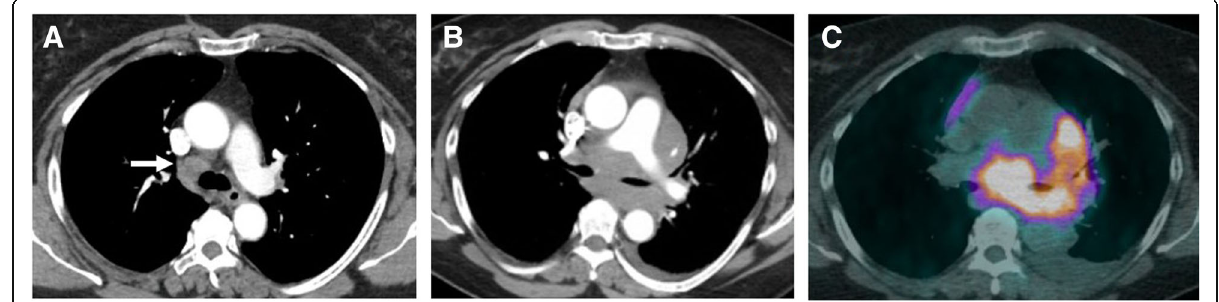
Fig. 1 A 60-year-old woman with grade I follicular lymphoma on rituxan, with new onset shortness of breath and atrial fibrillation. a Axial CT image of the chest acquired during arterial phase 1 year before onset of new symptoms shows mildly prominent mediastinal lymph nodes (arrow). b Axial CT image acquired during arterial phase at time of symptoms shows a large amorphous mediastinal mass surrounding the distal trachea and the pulmonary artery. c Axial PET/CT fused image of the chest acquired at time of symptoms shows avid FDG uptake of the mass, with SUVmax 20.1. The lesion was biopsied and showed grade III follicular